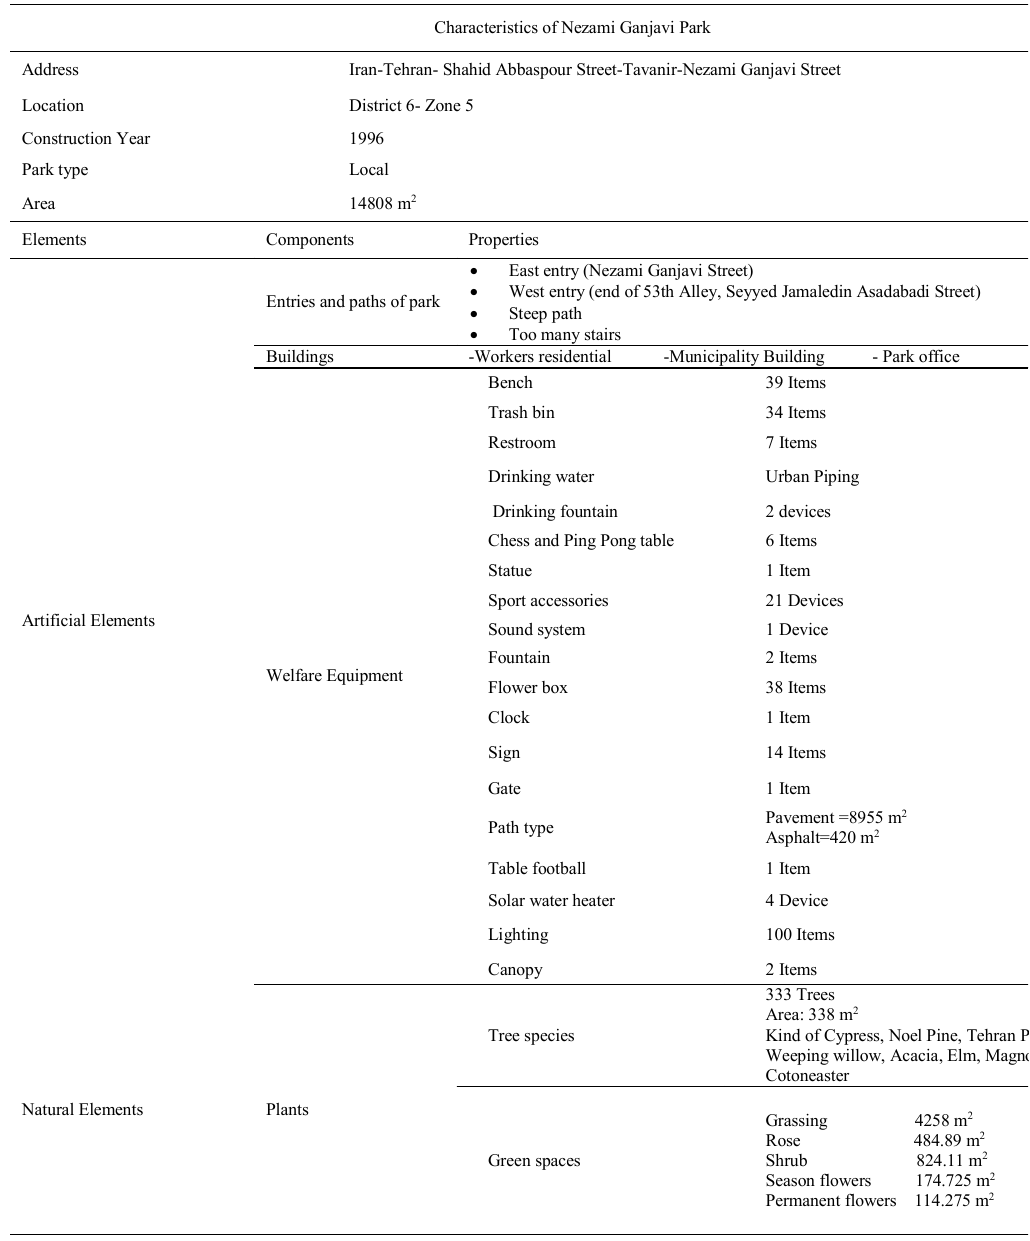
Table 1: Characteristics of Nezami Ganjavi